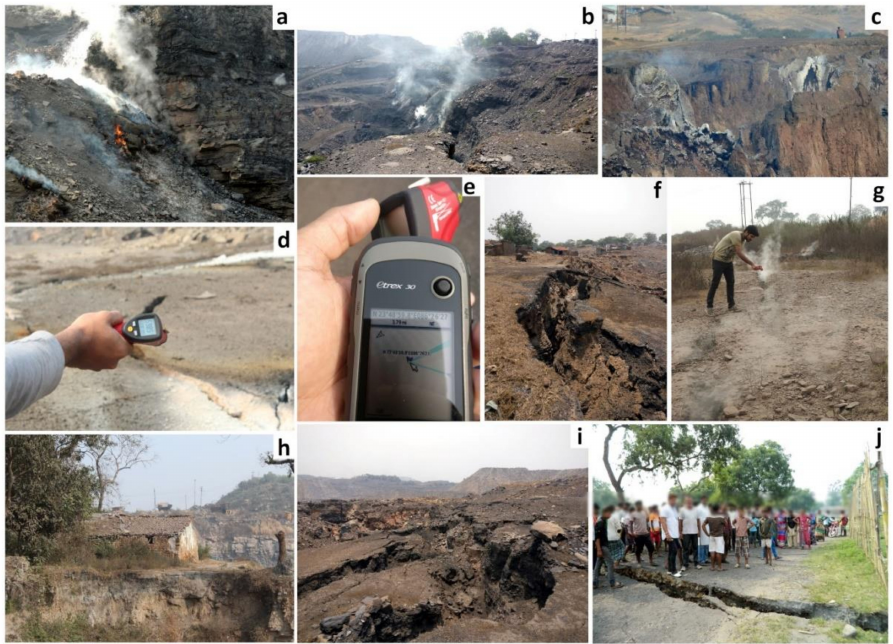
Figure A3. ( a ) A small part of the subsurface coal fire and associated smoke reaching the surface. ( b ) Smoke rising from exposed subsurface channels in an opencast mine boundary. ( c ) Rock deformations due to coal fire. ( d ) The thermal gun pointed towards the hot gases coming through a crack showing a temperature of 598 ◦ C. ( e ) Thermal gun and Garmin GPS used in the field measurements. ( f ) Sample of surface collapse. ( g ) Measuring the temperature inside a surface crack. ( h ) A house abandoned due to surface collapse risk. ( i ) Surface collapsed region. ( j ) Residents gathered to observe a newly formed deep